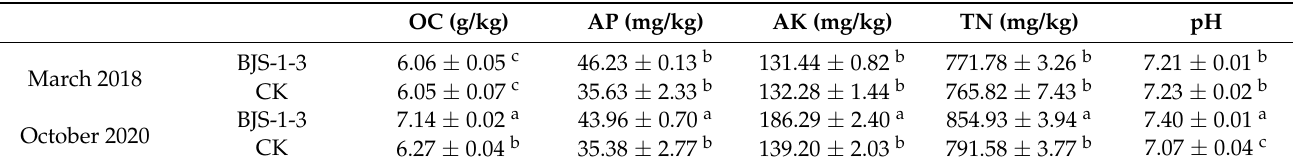
Table 2. Soil edaphic characteristics between March 2018 and October 2020.